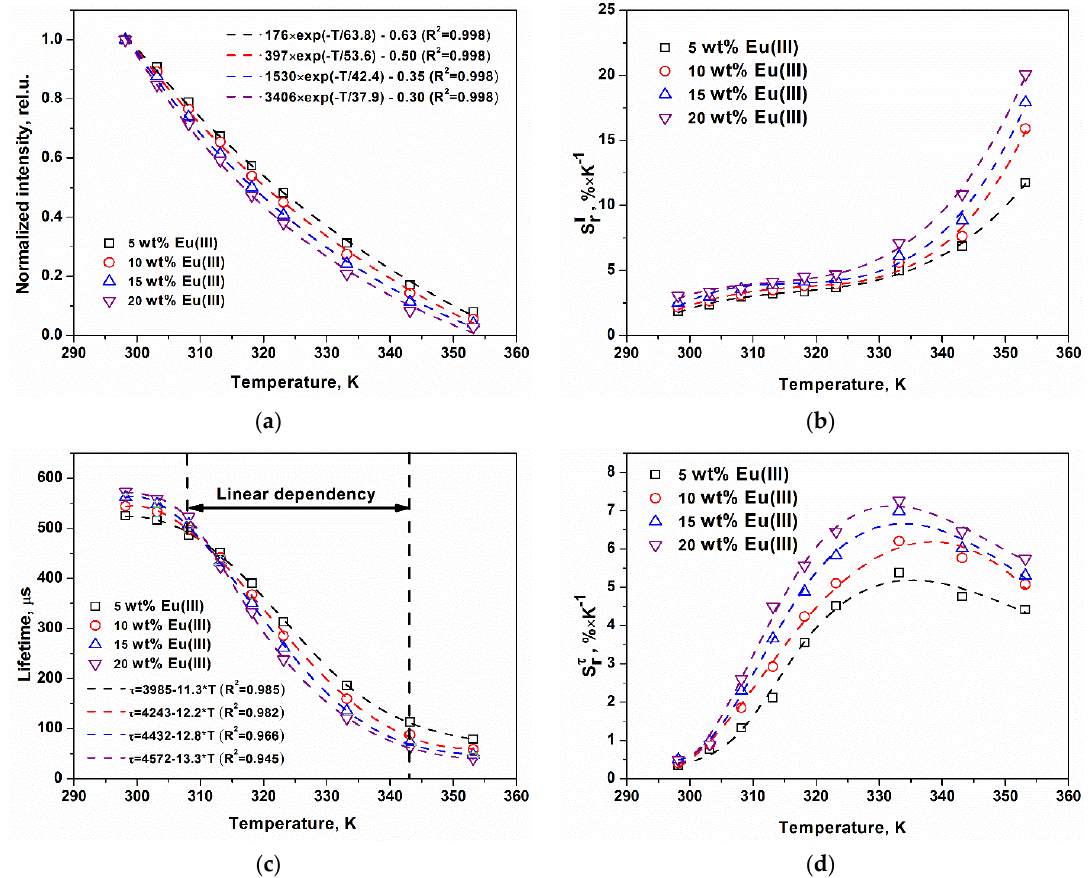
Figure 4. Temperature dependences of the normalized luminescence intensity ( a ), sensitivity of the normalized intensity (S rI ) ( b ), lifetime ( c ) and the luminescence lifetime (S r τ ) ( d ) obtained for the PLA composite films doped with a different content of the Eu(III) complex at λ ex = 340 nm and λ em = 613 nm (marker symbols—experimental data, dashed lines—approximations).